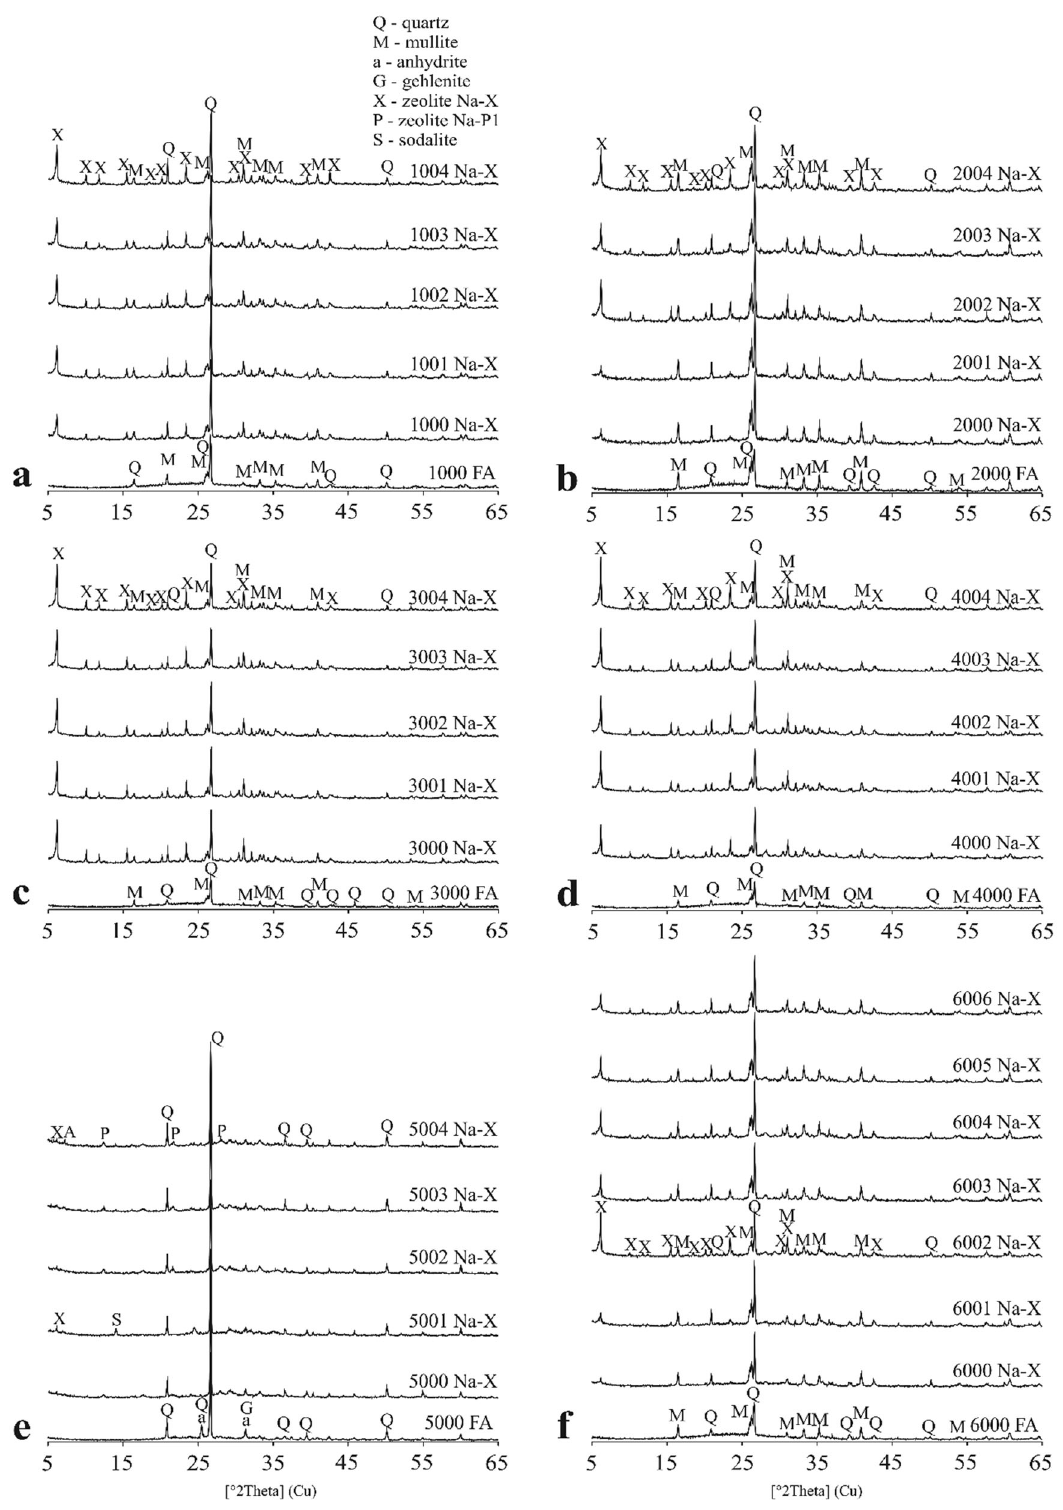
Fig. 5 XRD analyses of raw fly ashes and attempts of Na-X